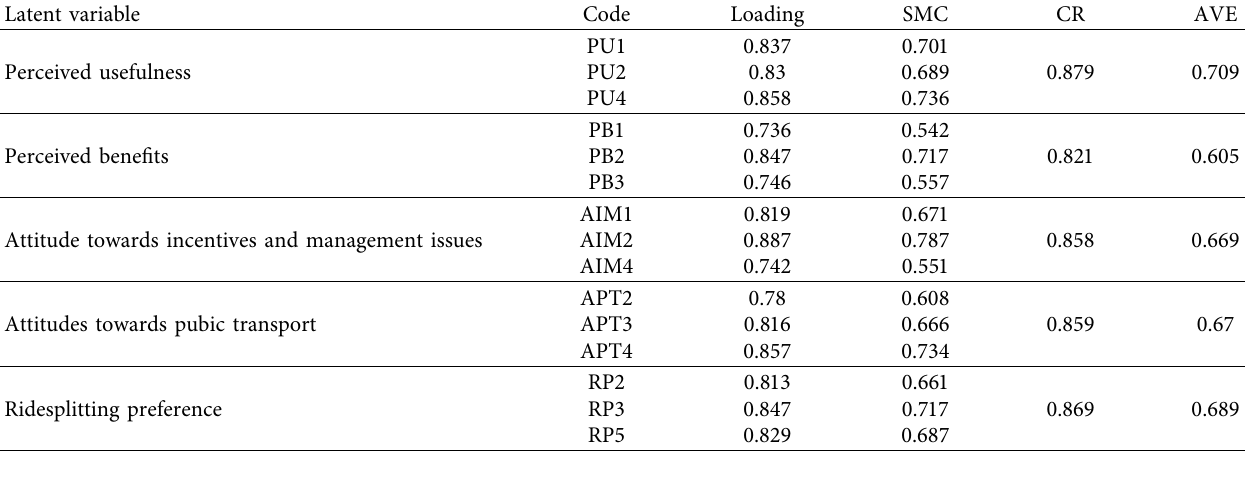
Table 5: Confirmatory factor analysis results.